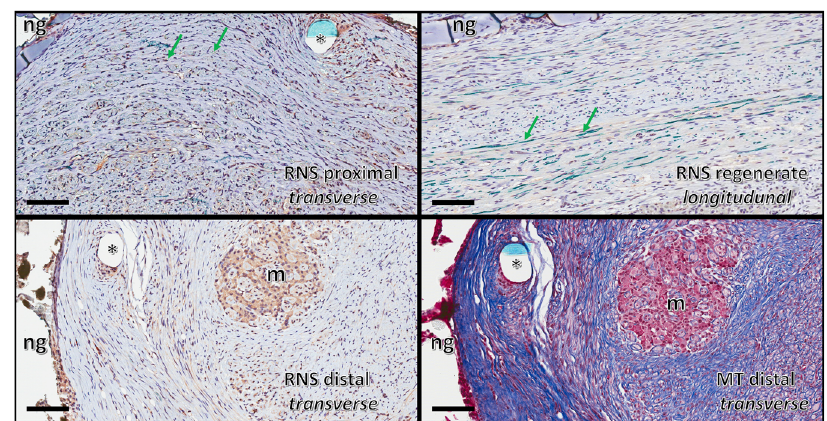
Fig. 8 The RNS staining of the region 1, 3, and 5 (proximal stump; regenerate; distal stump) 16 weeks post-implantation. They showed that myelinated fi bers (stained green; pointed by green arrows) are regenerating inside the nerve-guide, but fi brosis and debris scavenging are already well advanced in the distal stump. MT staining highlighted the collagen fi bers in dark blue. The transverse section of the nylon